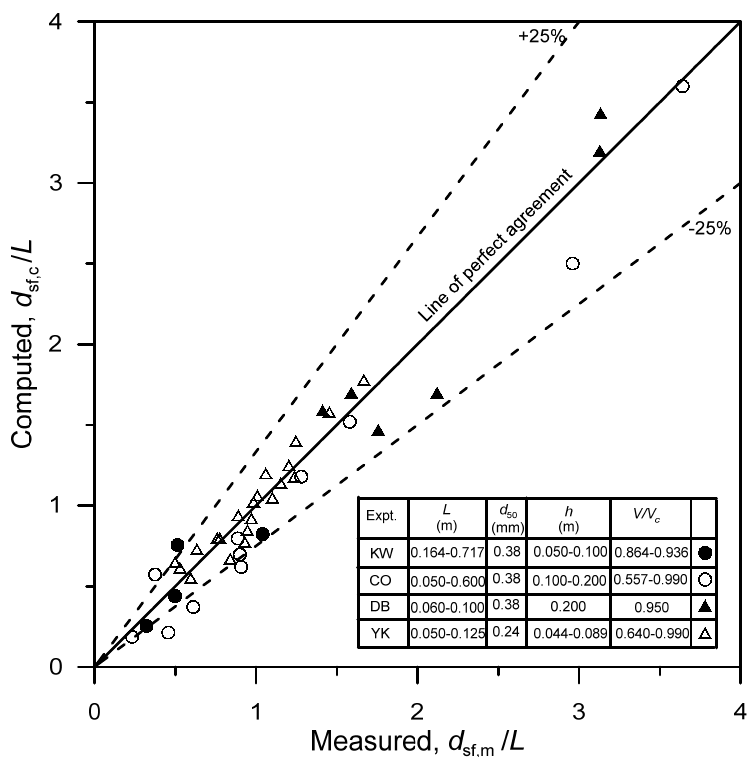
Figure 7. Comparison of final scour depth between the proposed model and the experimental data of KW (Kwan [26]), CO (Coleman et al. [18]), DB (Dey and Barbhuiya [19]), and YK (Yanmaz and Kose [20]).